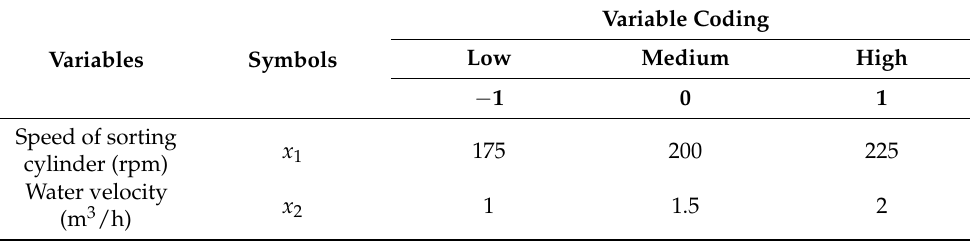
Table 4. Arrangement and coding table of independent variables in orthogonal experiment. Variable Coding Low Medium Variables Symbols